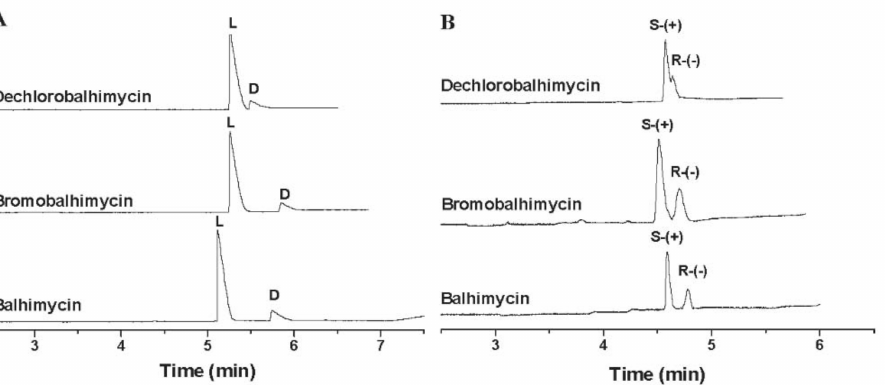
Figure 5. Enantio-separation of enantio-enriched l -dansyl-methionine ( A ); and ( S )-ketoprofen ( B ) by CE using balhimycin, bromobalhimycin, and dechlorobalhimycin as CS (CS concentration 2 mM). The figure is reproduced from Jiang et al. [45] with permission from